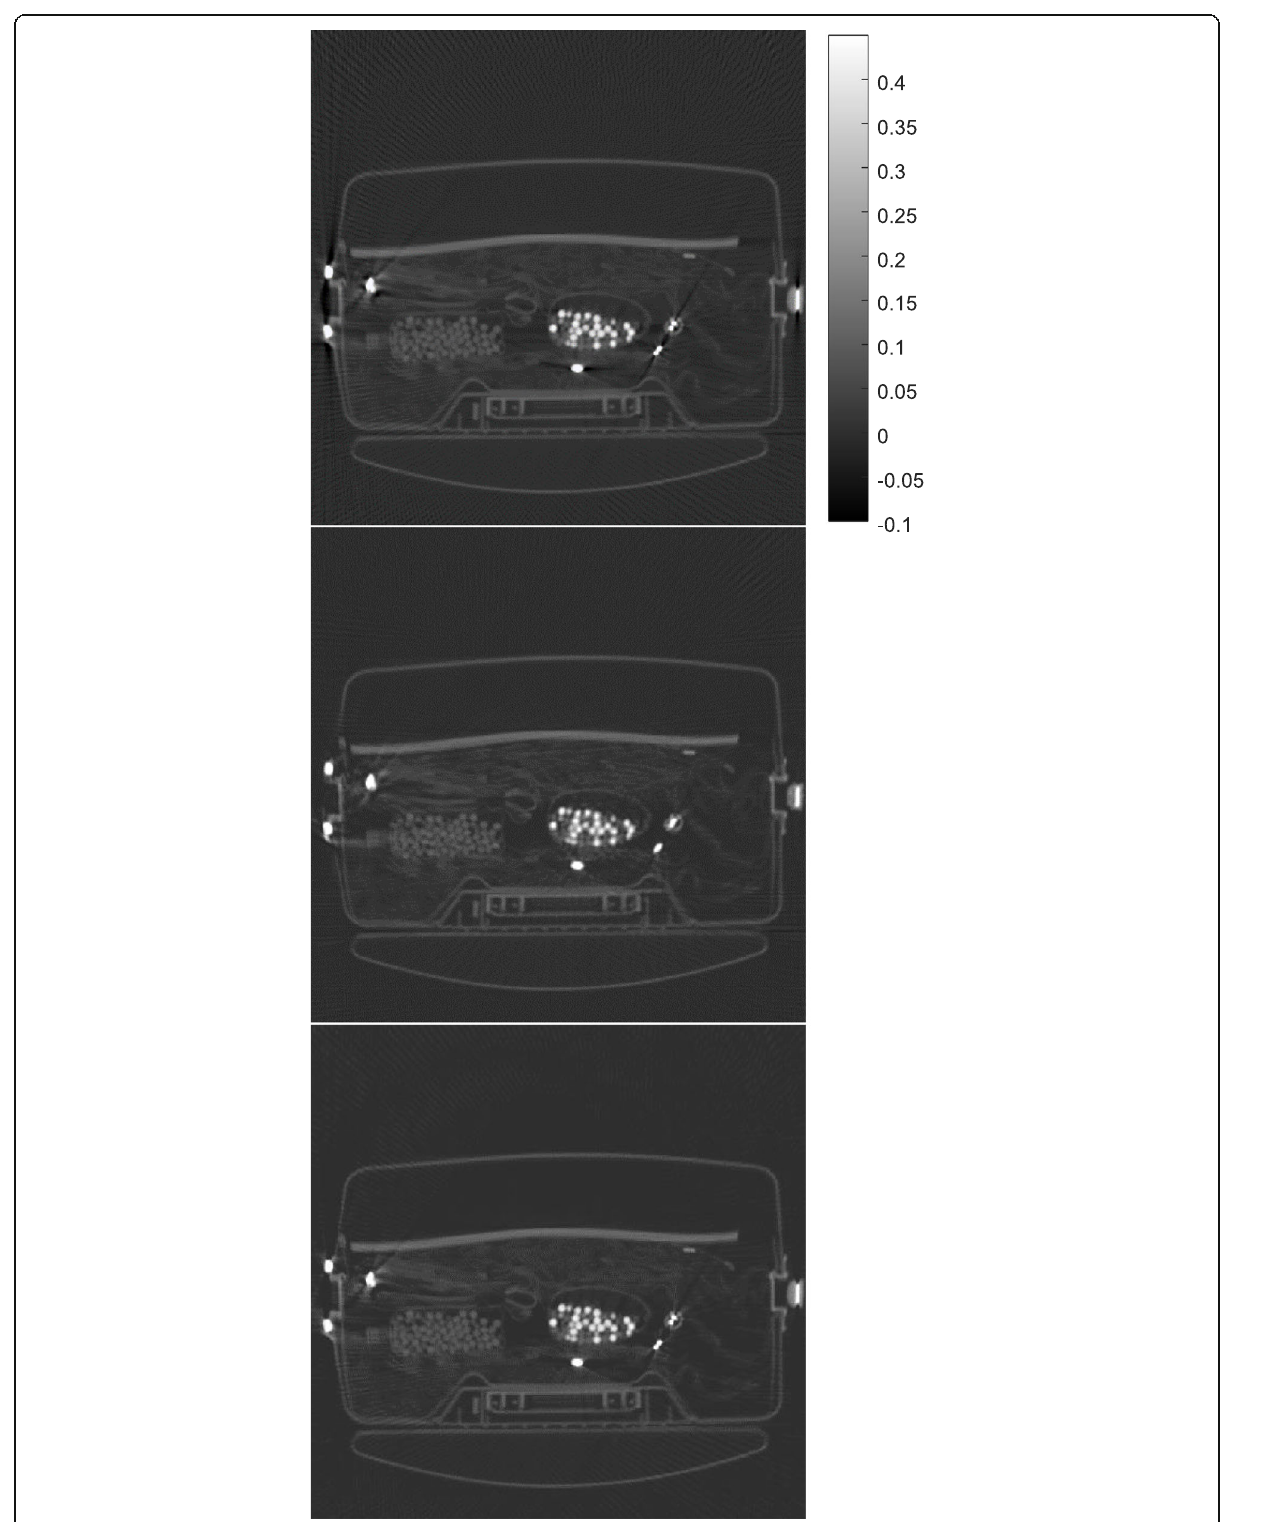
Fig. 4 CT image reconstruction of airport bag #4. Top: the raw FBP reconstruction; Middle: the reconstruction using the proposed algorithm; Bottom: the raw FBP reconstruction with all negative pixel values replaced by